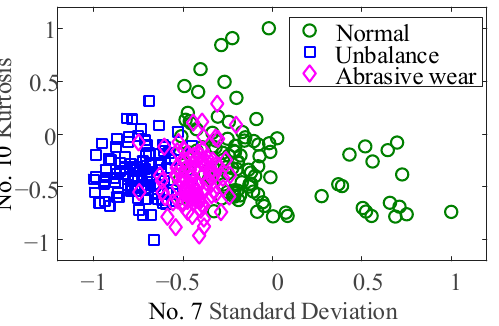
Figure 15. Scatter of sensitive features of standard Deviation and Kurtosis. Figure 15. Sca tt er of sensitive features of standard Deviation and Kurtosis. Figure 15. Sca tt er of sensitive features of standard Deviation and Kurtosis.